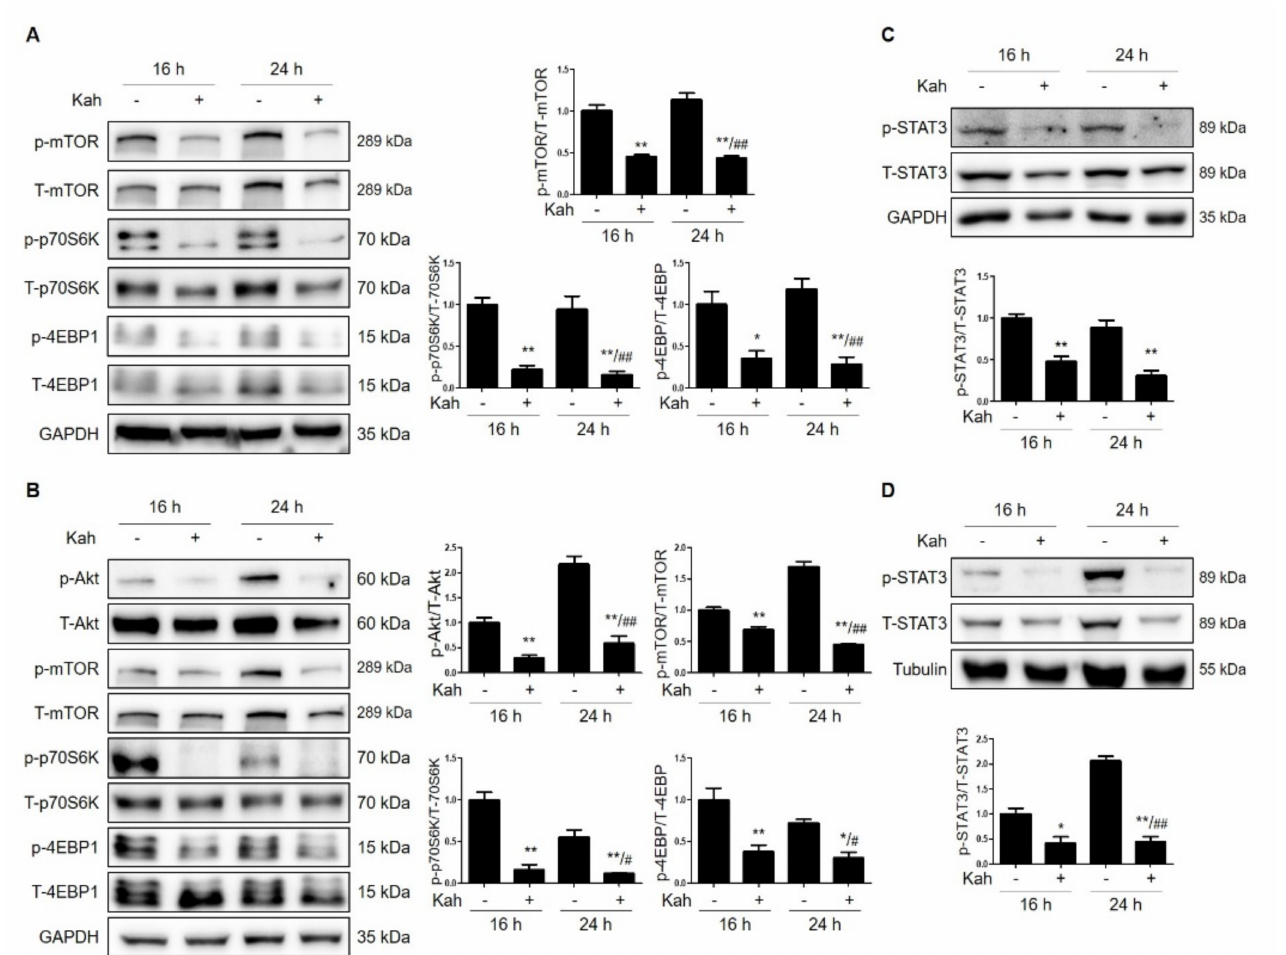
Figure 5. Kahweol blocks mTOR activation and decreases the level of p-STAT3 expression in HCC cells. ( A ) Hep3B and ( B ) SNU182 cells were treated with 40 µ M kahweol for 24 h. Western blot analyses show the effects of kahweol on the expression levels of p-Akt, p-mTOR, p-70S6K, and p-4EBP1. Data in the graph are represented as the mean ± SEM of three independent measurements, and graphs are normalized to 16 h control (without kahweol). * p < 0.05 and ** p < 0.01 relative to the 16 h control. # p < 0.05 and ## p < 0.01 relative to the 24 h control (without kahweol). ( C ) Hep3B and ( D ) SNU182 cells were treated with 40 µ M kahweol for 24 h. Western blot analyses show the effects of kahweol on the expression levels of p-STAT3. Data in the graph are represented as the mean ± SEM of three independent measurements, and graphs are normalized to 16 h control (without kahweol). * p < 0.05 and ** p < 0.01 relative to the 16 h control. ## p < 0.01 relative to the 24 h control (without